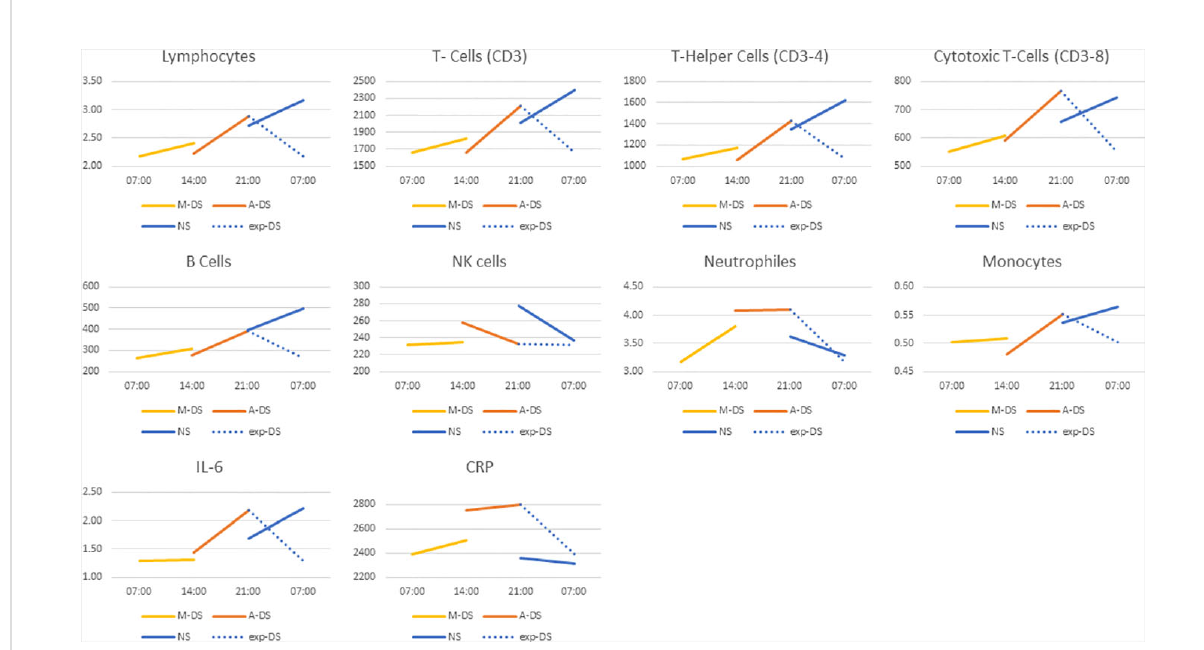
FIGURE 2 Mean values of biomarkers levels by shift group measured at start and end of the work shift (MS, Morning shift; AS, Afternoon shift; NS, Night shift; exp-DS, expected variation of biomarker level among day shifters between 21:00 and